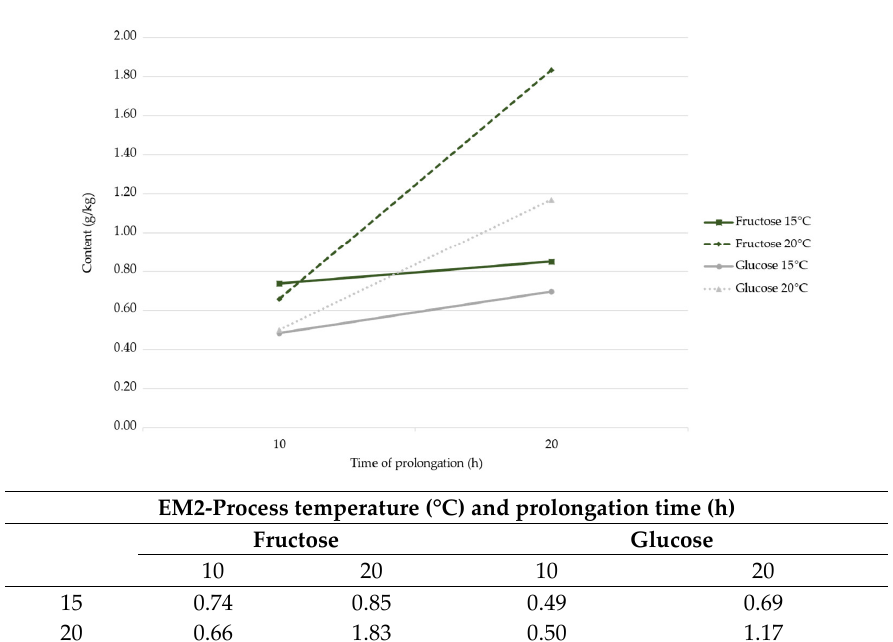
Figure 5. Effect of prolonged mucilage fermentation on coffee sugars in the EM2 maturity stage according to Duncan’s test (α = 0.05). according to Duncan’s test ( α =